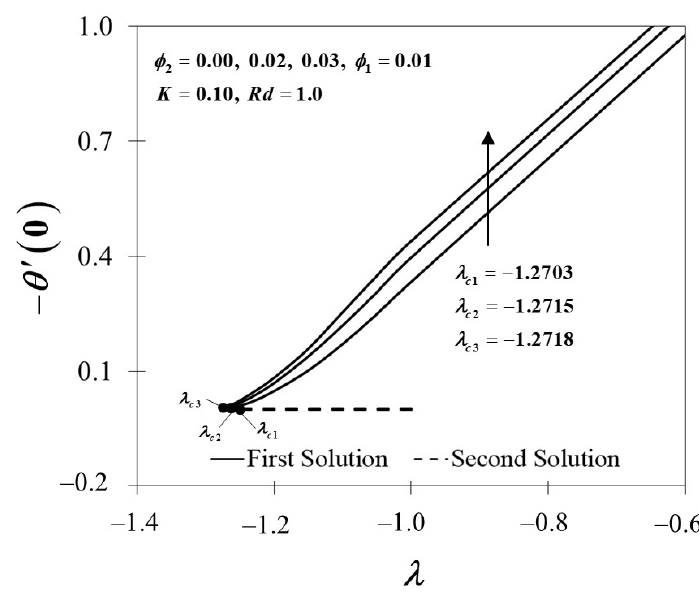
( ) 0 θ′− towards λ by assorted